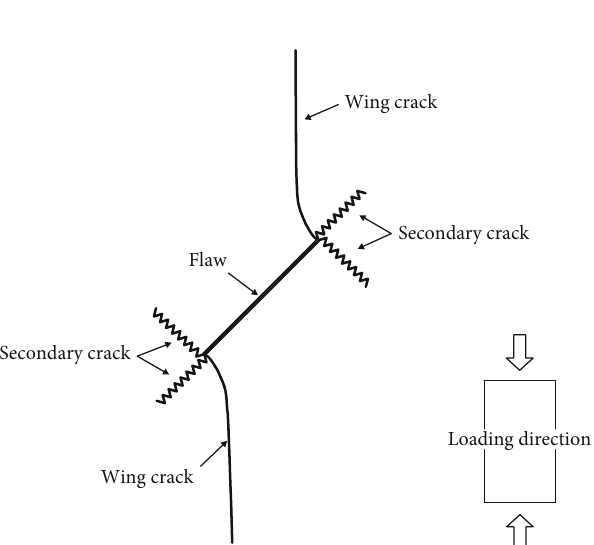
Figure 1: Simpli fi ed crack pattern in precracked specimens under uniaxial compression